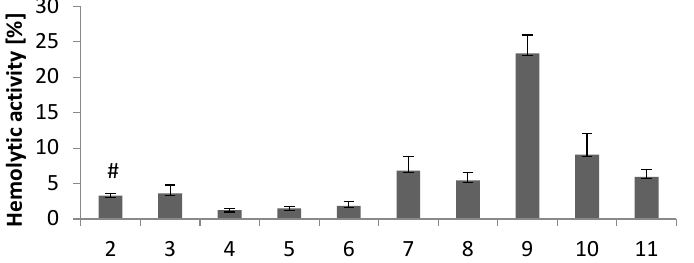
Figure 5. Hemolytic activity of compounds 2 – 11 at a concentration of 0.1 mg/mL. Results ( n = 7) are presented as the mean value ± standard deviation. # Data published in [18].